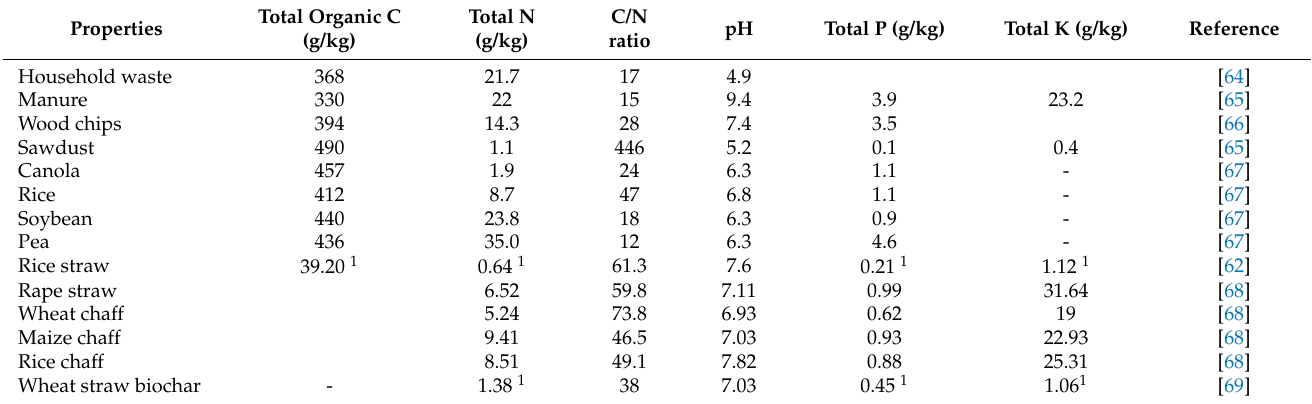
Table 2. Physiographical properties of organic feedstock materials or different